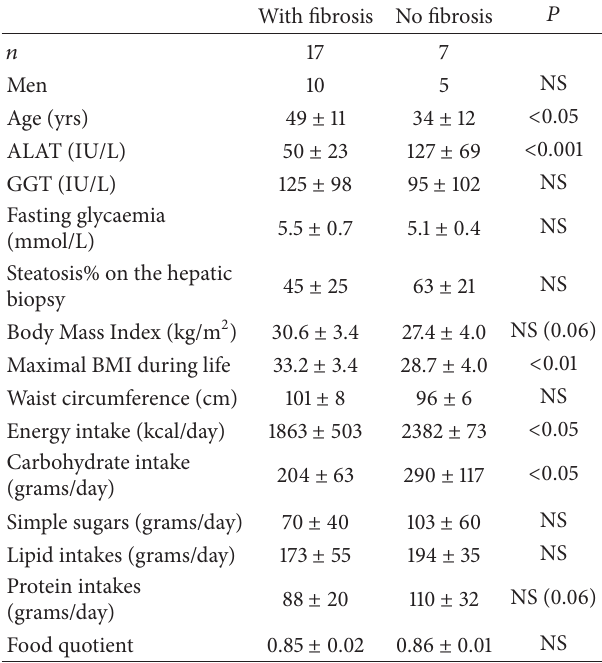
Table 1: Comparison of the subjects with versus without liver